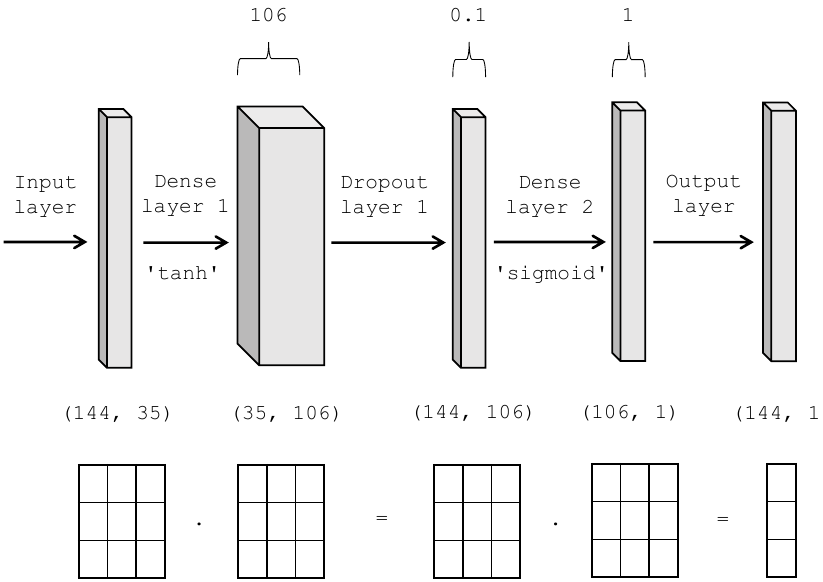
Figure 2. Proposed ANN architecture; dense layer implements the operation: output = activation ( dot ( input , kernel ) + bias ) , where activation is the element-wise activation function, kernel is a weights matrix, and bias is a bias vector; dropout is a regularization layer that randomly sets input units to 0 with a frequency of rate at each step during training time, which helps prevent